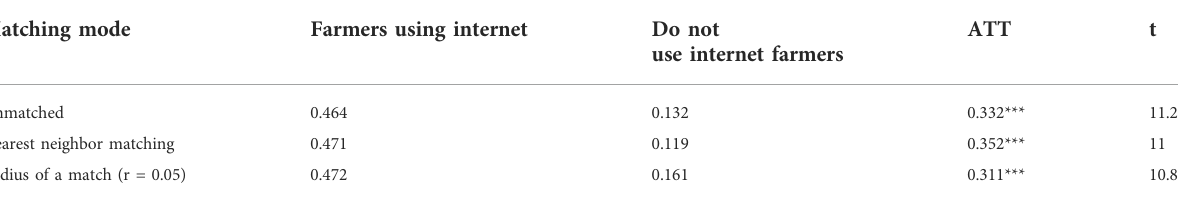
TABLE 8 Regression results of robustness test